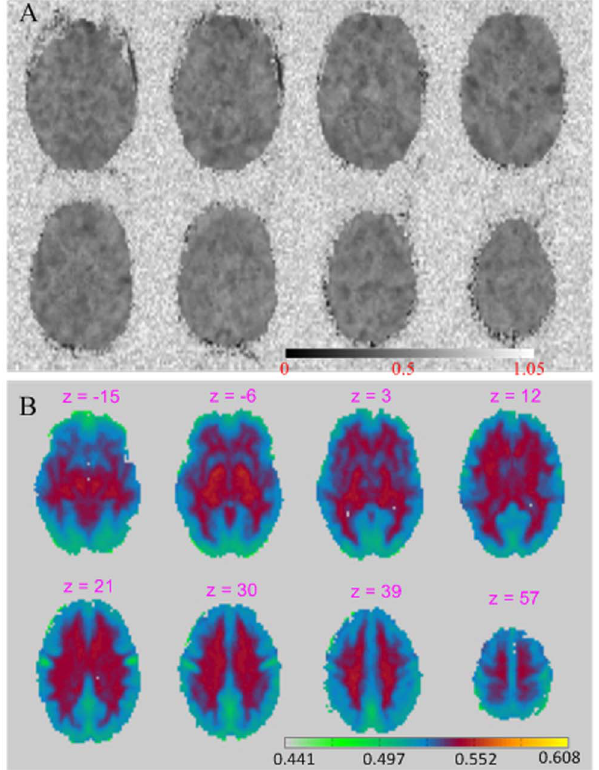
Figure 2. The BEN maps with and without background. A) BEN map of a representative subject. B) average BEN map of 1049 subjects. The background voxels were removed for a better visualization.The gray scale and color scale indicate BEN values for Figure 2a and 2b, respectively.